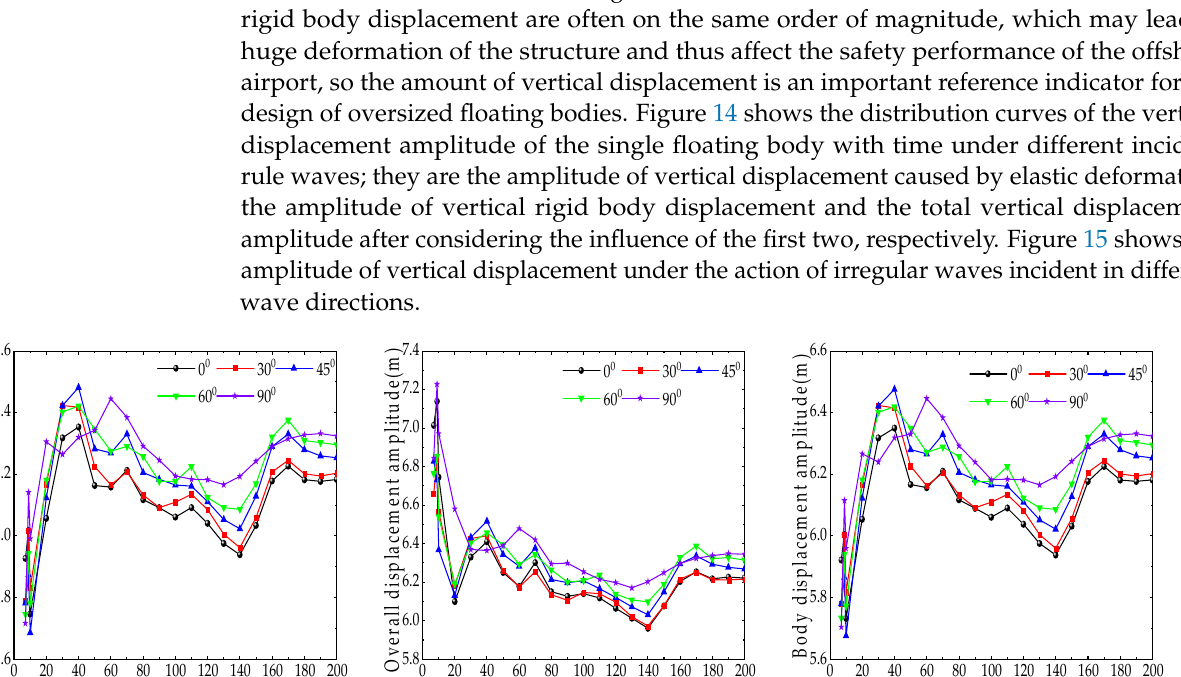
0 20 40 60 80 100 120 140 160 180 200